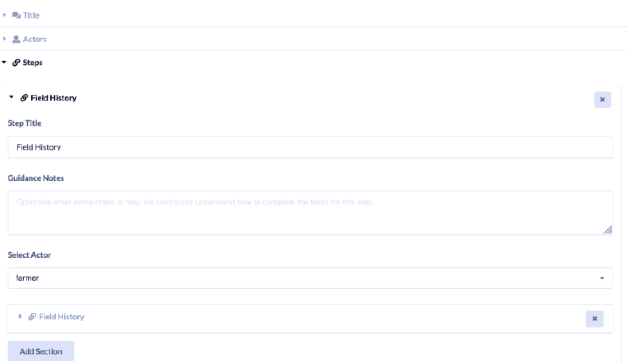
Figure 2: The SICCAR DLT platform’s process design user interface (see